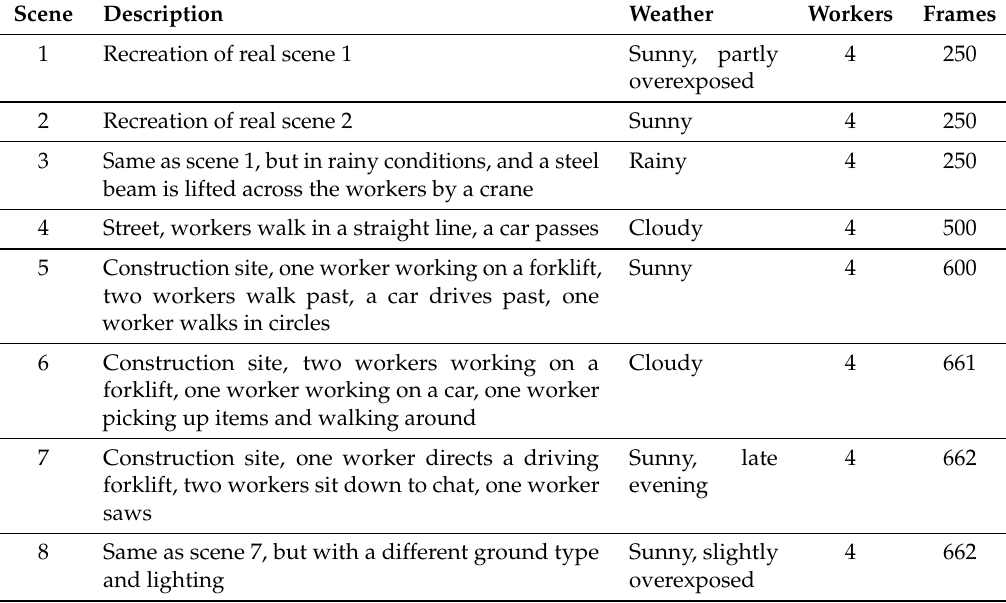
Figure 2. Process for creating synthetic scenes. Table 1. Descriptions of the created computer generated